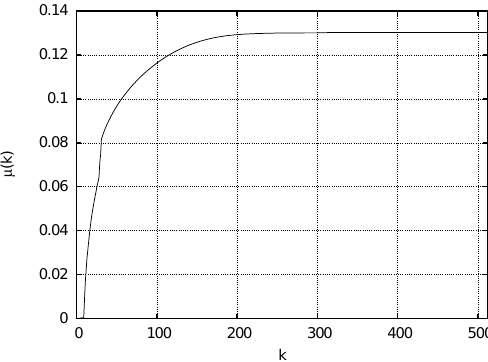
Figure 11. Spectral line of the harmonic k = (0, 100). Only the con- densate was suppressed.